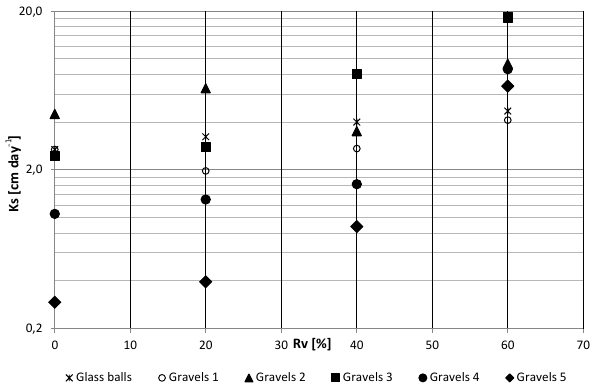
Fig. 3 – 𝐊 𝐬𝐞 depending on 𝐑 𝐯 obtained from laboratory experiments with gravels (5 replications) and glass balls (1 replication). Figure 3. K se depending on R v obtained from laboratory experi- ments with gravels (five replications) and glass balls (one replica- tion).